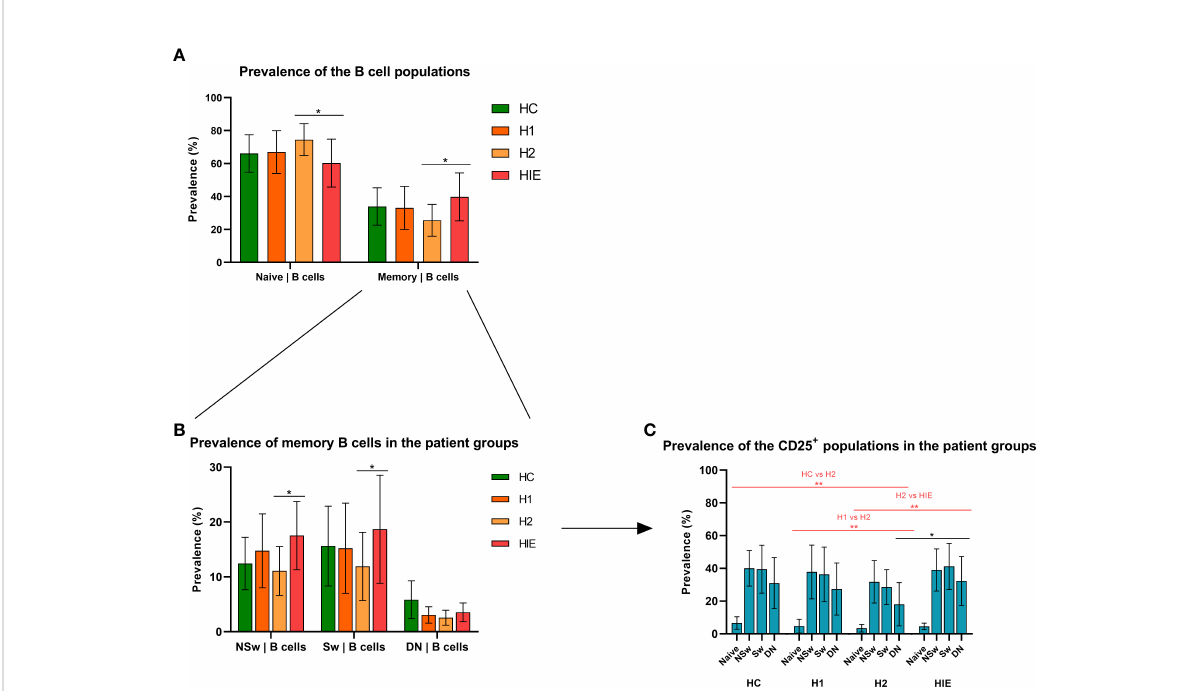
FIGURE 2 Different naive and memory B cell ratio in levothyroxine treated and ATA+, euthyroid, infertile patients Prevalence of naive and memory B cell subsets (A) , B cell memory subpopulations (B) and CD25 + B cell subpopulations (C) HC: healthy controls (n=12); HT: Hashimoto ’ s thyroiditis, H1: hypothyroid patients with HT before treatment (n=14); H2: euthyroid patients with HT, after levothyroxine-treatment, (n=12); HIE: HT, infertile, euthyroid patients (n=14); NSw: non-switched; Sw: switched, DN: double negative memory B cells. Differences between the groups and within the B cell subpopulations were assessed with two-way ANOVA and Tukey ’ s post hoc test except H1-H2 comparisons where a mixed-effects analysis and the Sidak ’ s multiple comparisons tests were used because these groups represent the same individuals in a repeated sampling before and during treatment. Bars represent the mean ± standard deviation (SD) of percentages of lymphocyte subpopulation in each group. *p < 0.05, **p <